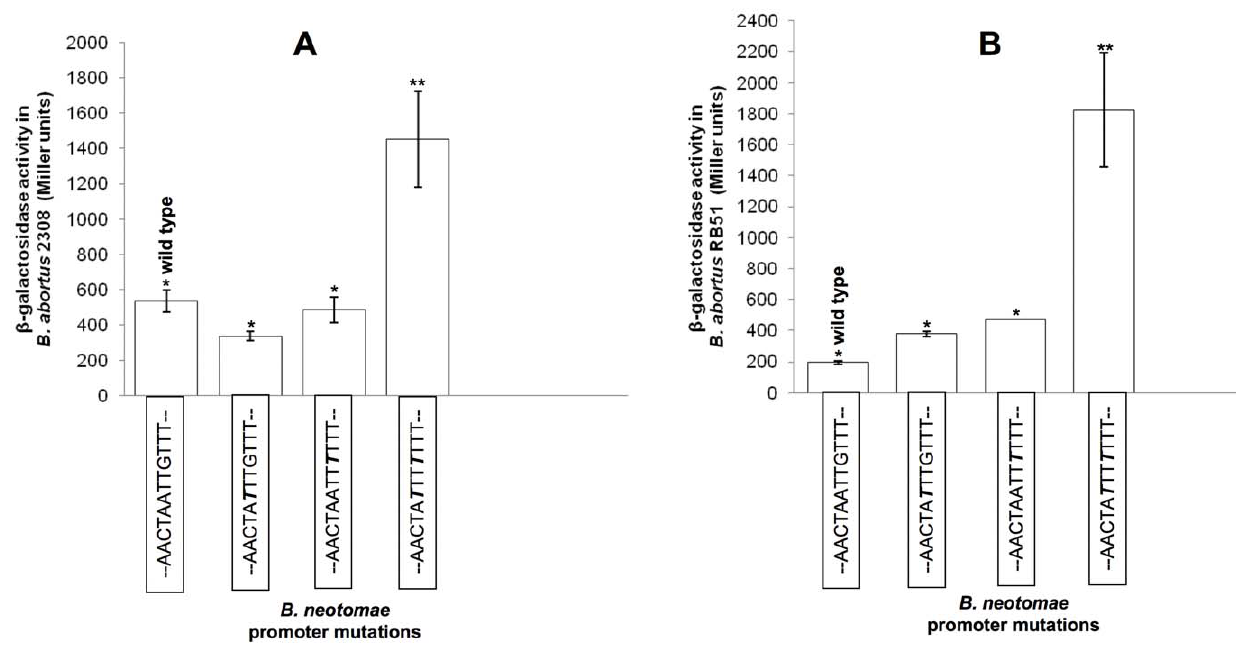
Figure 8. b -Galactosidase activity in B.abortus virulent strain 2308 (A) and B.abortus vaccine strain RB51 (B) transformed with plasmids containing lacZ gene under the control of wildtype and the indicated mutated B.neotomaesodC promoters. For each promoter construct, the assays were performed using 3 separate colony cultures. Results are shown as the mean 6 standard deviation of Miller units. In each panel, means with the same number of asterisks were not significantly different from each other ( P . 0.05), but there were significant differences between means with different number of asterisks ( P , 0.001).